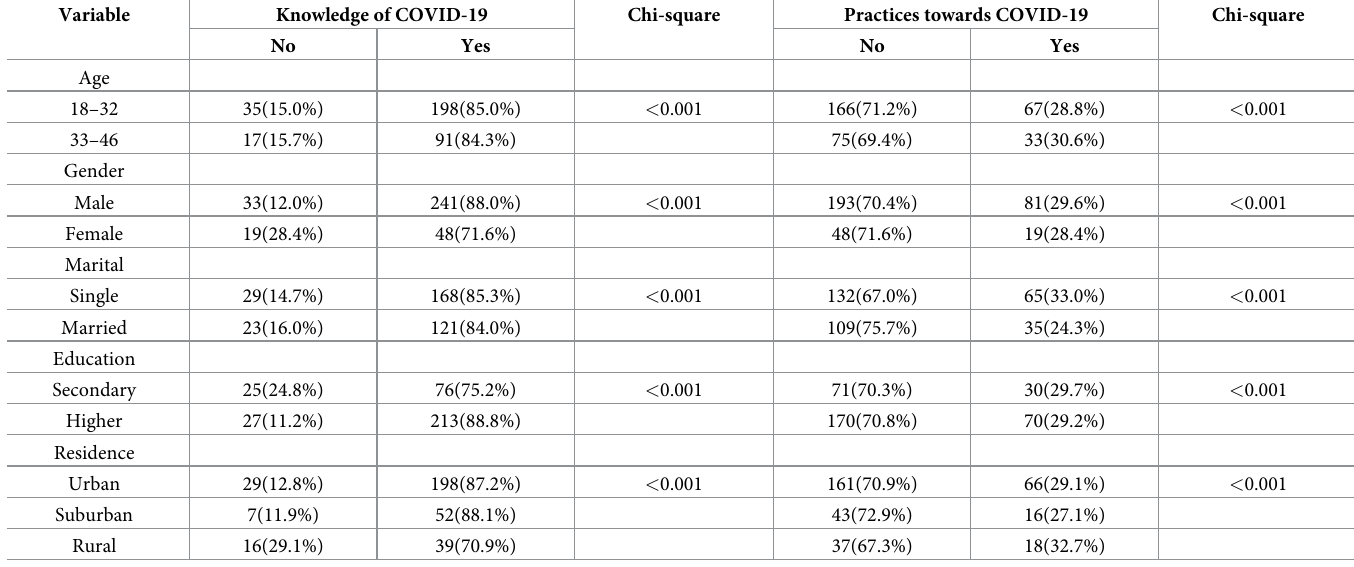
Table 5. The bivariate analysis of the sociodemographic factors with their knowledge and practice towards COVID-19 among residents of Ethiopia (N = 341).